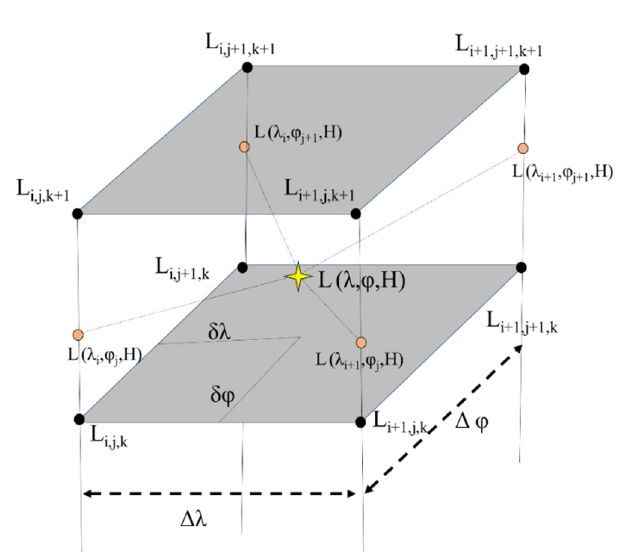
Figure 4. Interpolation of the meteorological parameters.